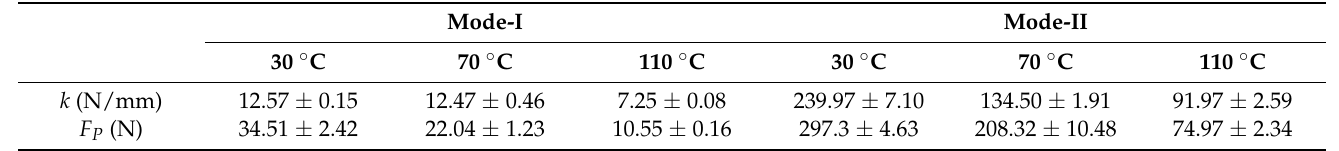
Figure 2. Setup of ( a ) Mode-I and ( b ) Mode-II delamination. Table 3. Mode-I and Mode-II delamination properties at each temperature [27,28] .